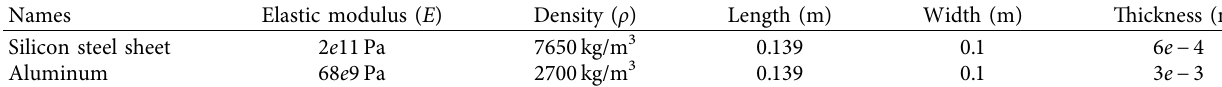
Table 4: Physical parameters of beams.